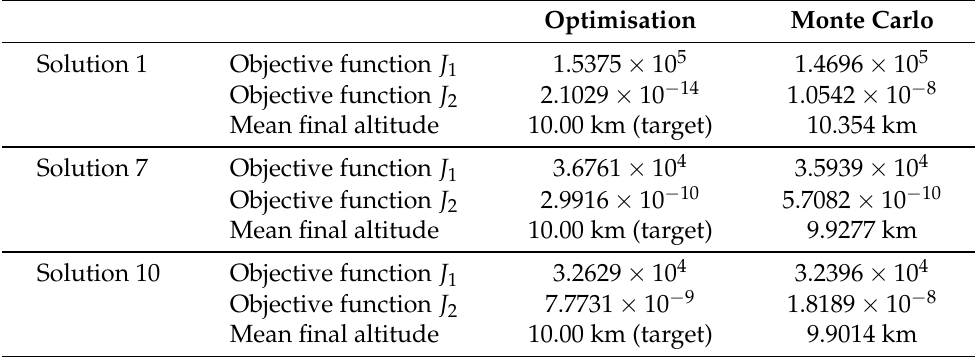
Table 2. Comparison of the mean value of the objective functions across the 100 runs of the Monte Carlo analysis with the optimised